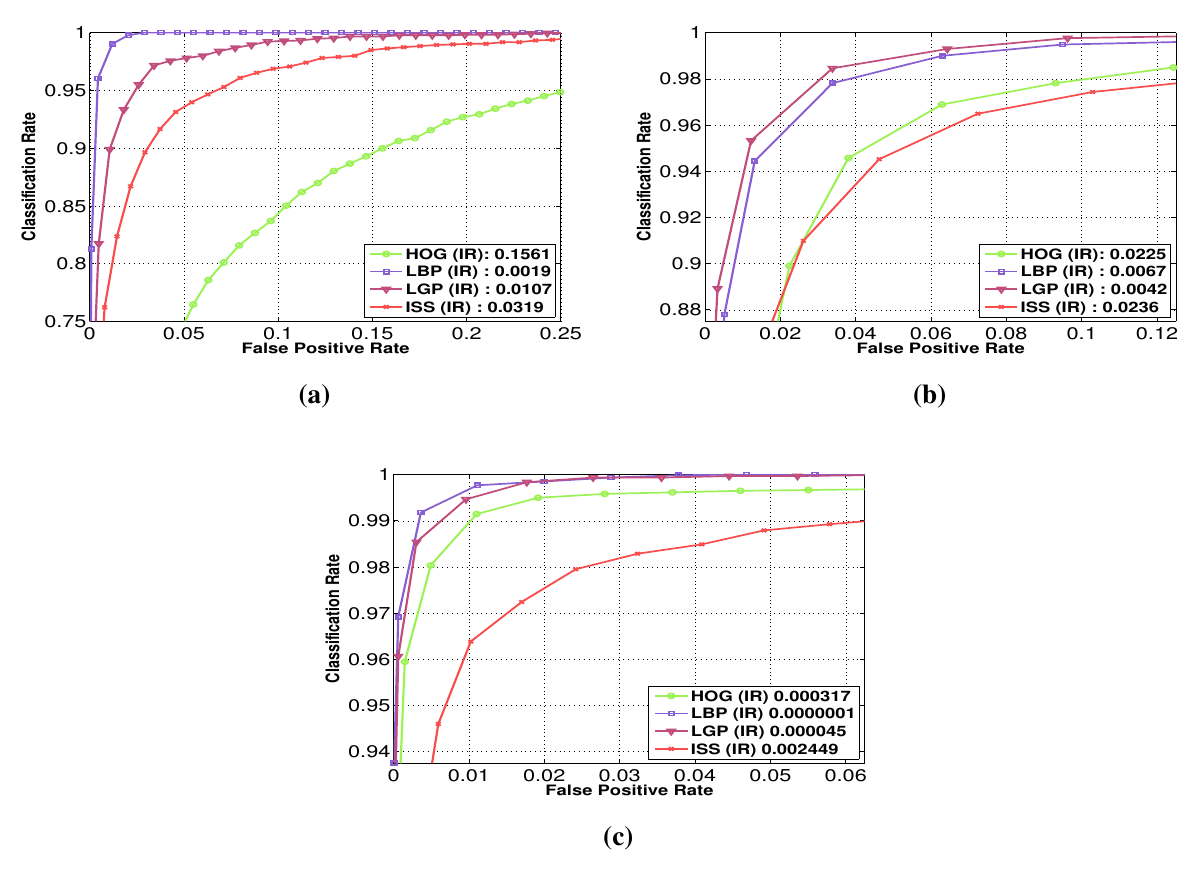
Figure 7. Performance comparison for HOG, local binary patterns (LBP), local gradient patterns (LGP) and intensity self-similarity (ISS) features in the FIR spectrum on the datasets: ( a ) RIFIR; ( b ) Parma-Tetravision; ( c ) OlmedaFIR-Classif. The reference point is considered the obtained false positive rate for a detection rate of